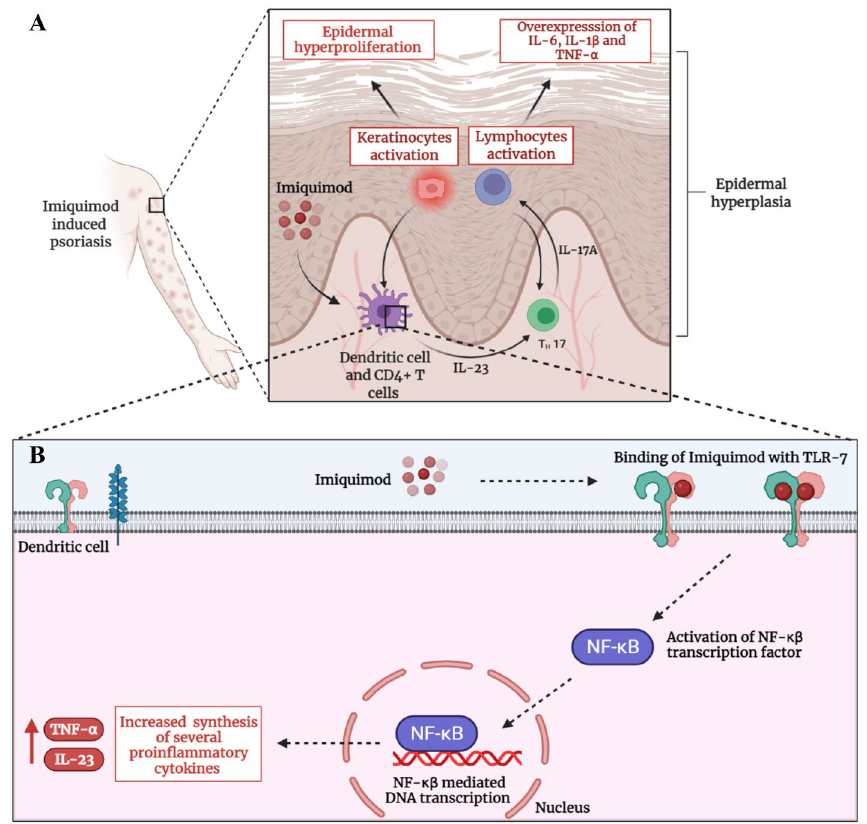
Figure 1. ( A ) Mechanistic illustration of IMQ induced psoriasis. ( B ) IMQ induced hyper-stimulation of NF-κβ and hyper-production of pro-inflammatory cytokines in dendritic cells. Created with